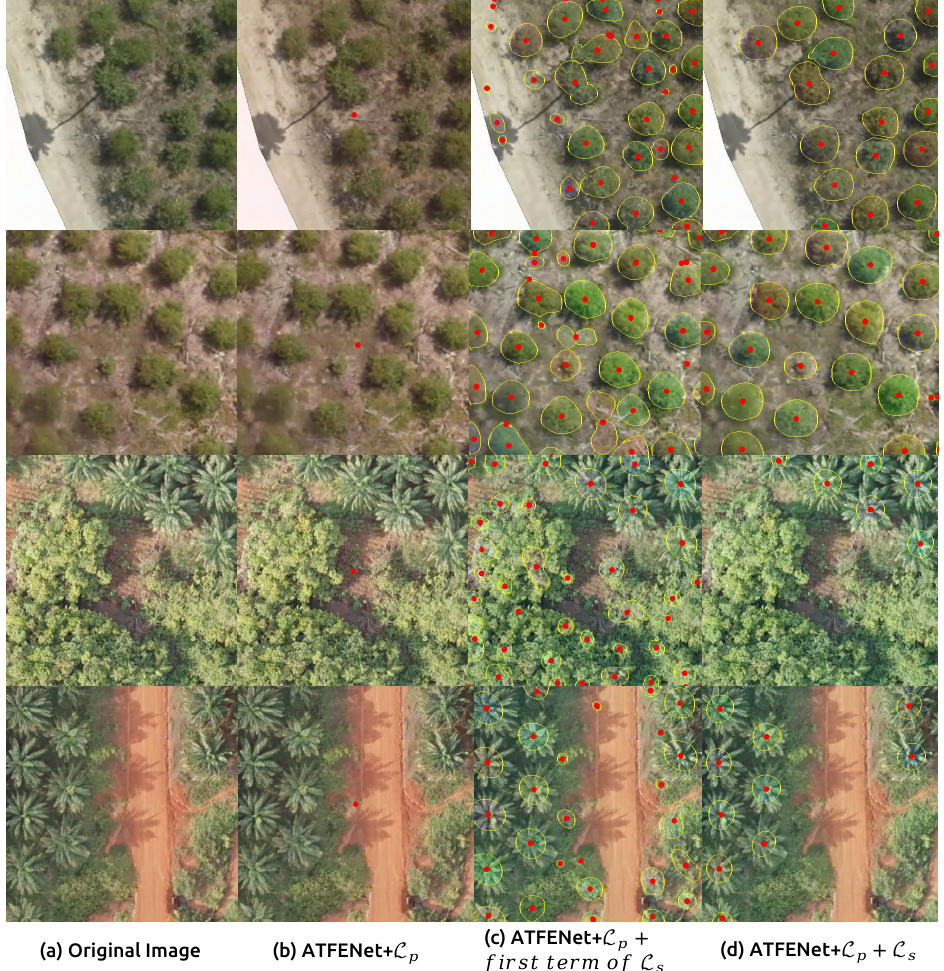
X Gy yX G  ℒ  Figure 10. The qualitative results of tree counting network trained with different terms of the proposed loss function. ( a ) Test images selected from acacia and oil-palm dataset. ( b ) Inference results just using point loss. ( c ) Prediction results improved with point loss and the first term of separate loss. ( d ) The performance both using point loss and separate